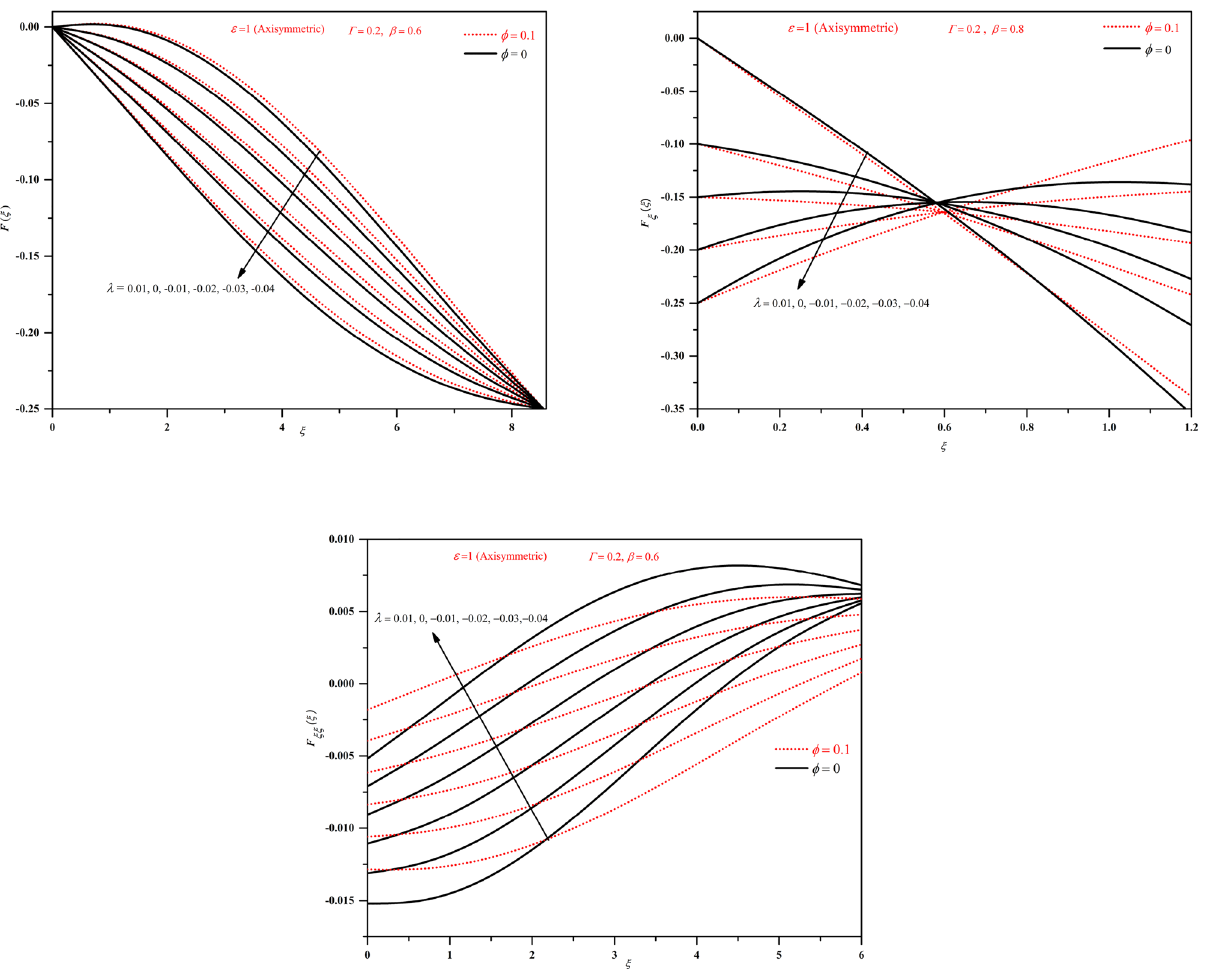
Figure 5. Plots of F , F ξ and F ξξ by varying (cid:31) (shrinking wall (cid:31) < 0 ) in the axisymmetric